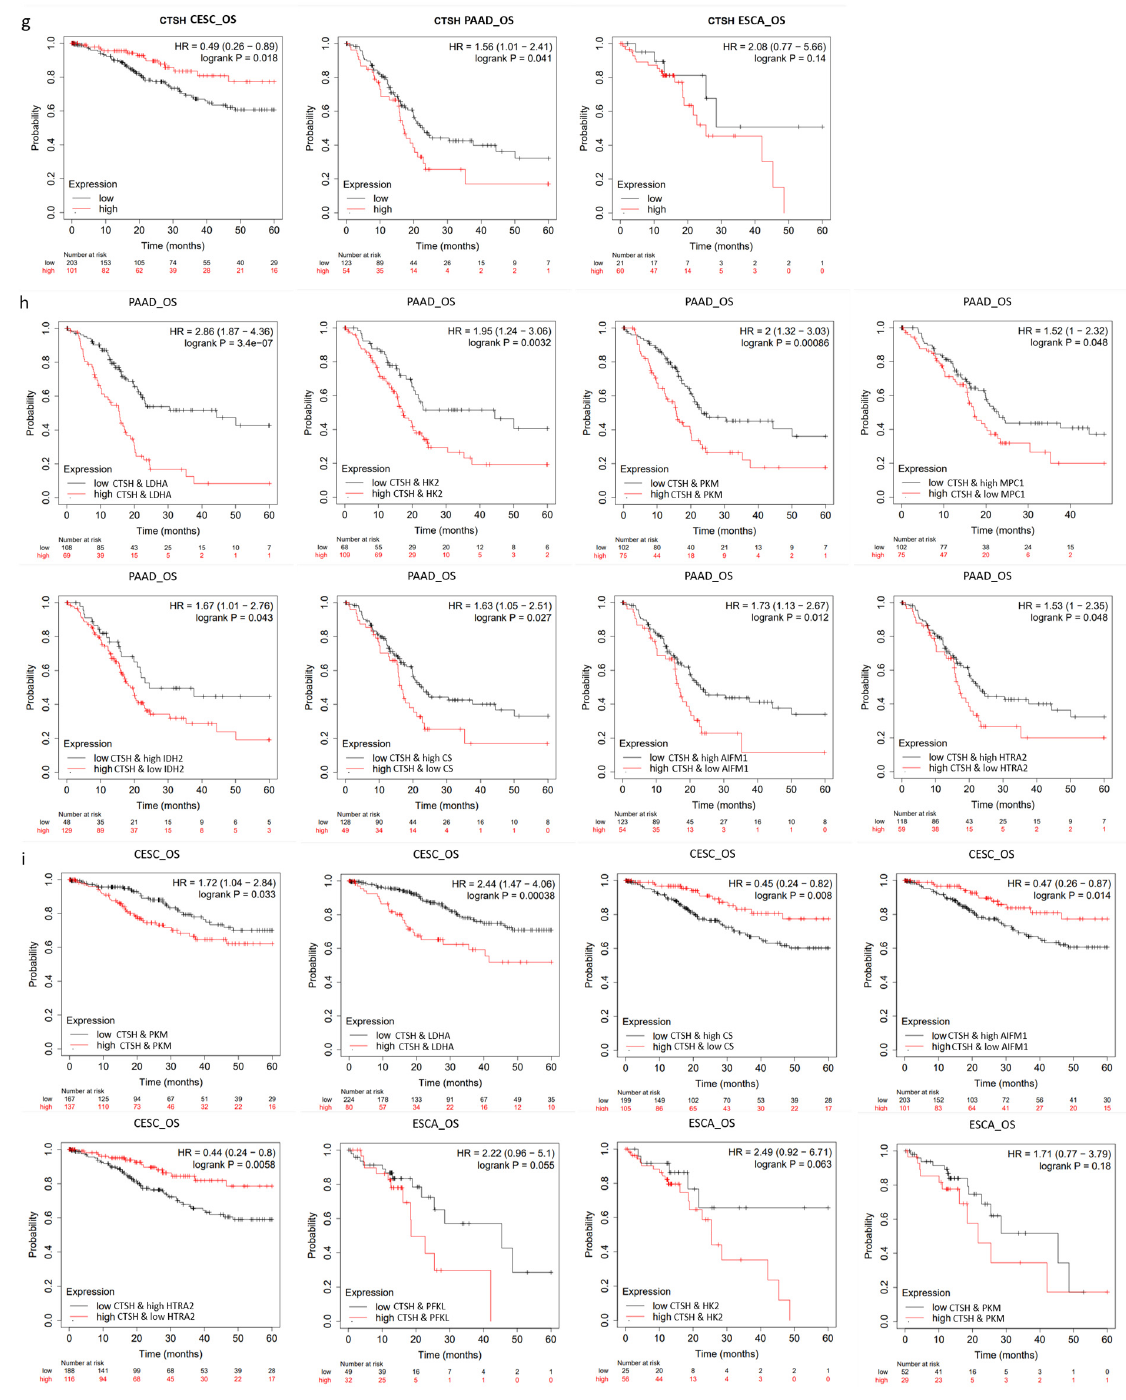
Figure 6. CTSH and Its Targets Were Correlated with Tumorigenesis and Poor Prognosis. ( a ) Expression of CTSH gene in HCC tumor and normal tissues by GEPIA; ( b ) Kaplan–Meier survival plot of CTSH gene expression of HCC by Kaplan–Meier Plotter; ( c ) Survival plot of CTSH protein expression between high and low level analyzed by The Human Protein Atlas; ( d ) Multi-gene expression analysis of CTSH with its downstream targets by TNMplot; ( e ) Survival plot of CTSH gene combined with its targets’ expression in HCC; ( f ) Expression profile of CTSH between tumor and normal tissues in human cancers; ( g ) Survival plot of CTSH gene in cervical squamous-cell carcinoma (CESC), pancreatic adenocarcinoma (PAAD), and esophageal squamous-cell carcinoma (ESCA); ( h , i ) Survival plot of CTSH combined with its targets’ expression in the above cancers; * p < 0.1; *** p < 0.01.